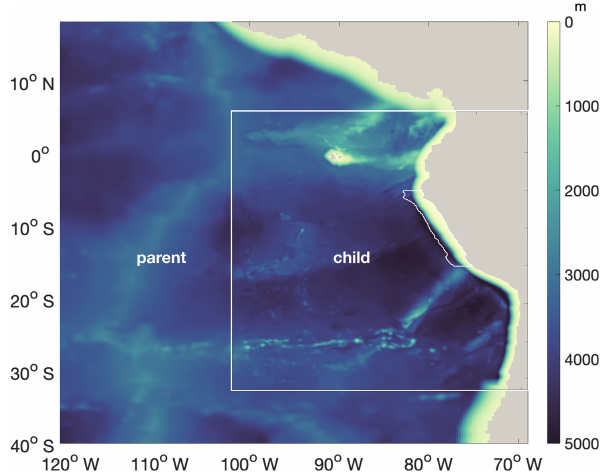
Figure A1. Bathymetry of the “parent” (1 / 4 ◦ resolution) and “child” (1 / 12 ◦ resolution) domains. White lines near the coast high- light the focus